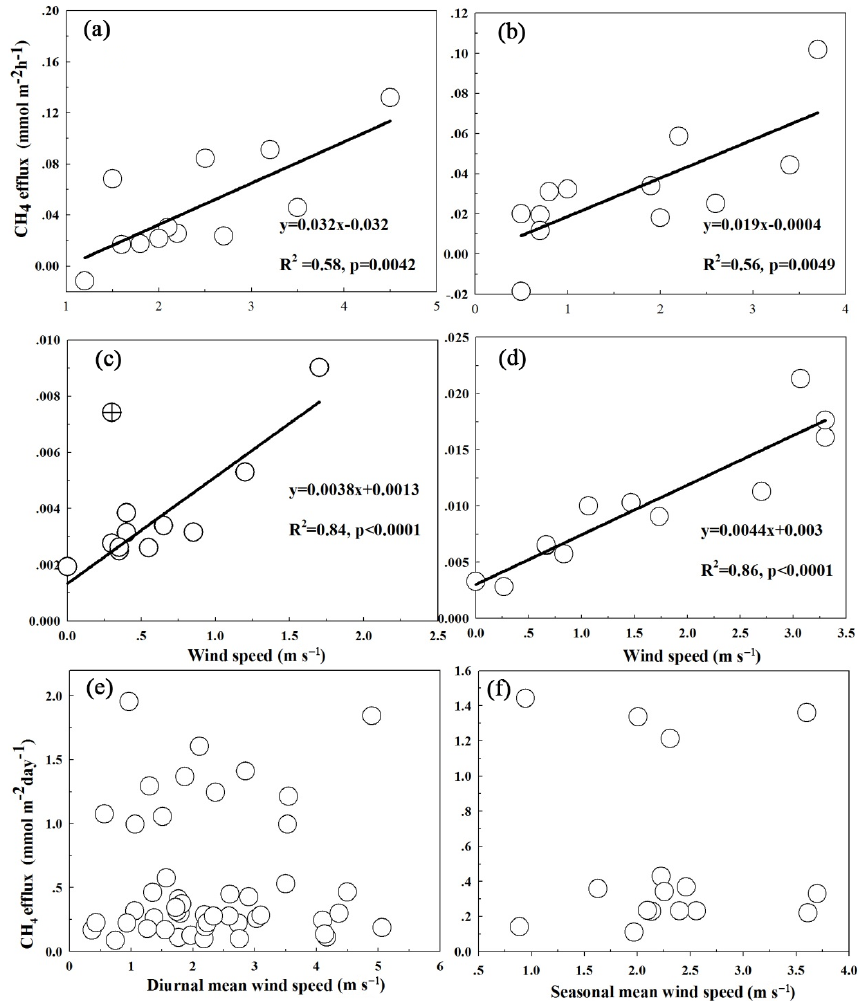
Figure 7. Relationships between CH 4 effluxes and wind speed in Poyang Hu. White circles represent the observed values of CH 4 effluxes and wind speed. Different panels mean the variations of CH 4 effluxes at a bihourly interval within 1 day, including in 24–25 July 2011 (a) , 5–6 September 2012 (b) , 13–14 January 2013 (c) , and 14–15 January 2015 (d) , on a diurnal scale (e) , and on a seasonal scale (f) . Panels (e, f) include all the measurements during the observation period. We excluded the white circle with black cross in (c) in the regression analysis because of a severe cold